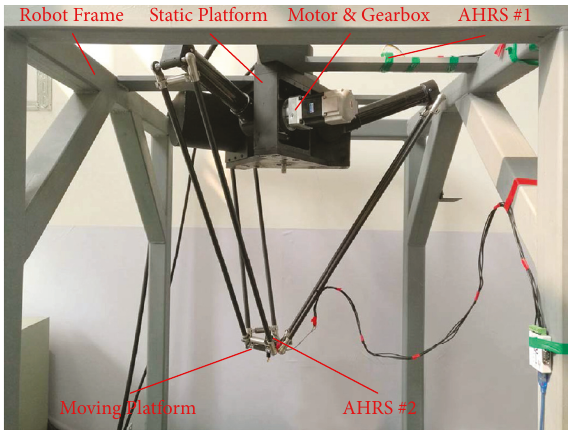
Figure 8: The robot experiment platform.